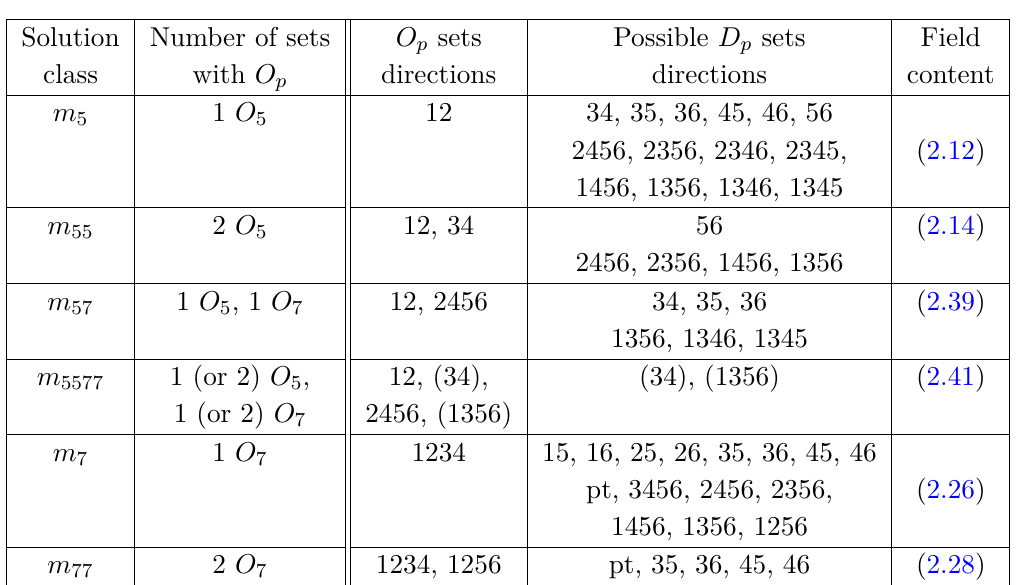
, together with the associated list of allowed variables or field p , 2 O , or 2 O , 1 O , or 2 O , 2 O form just 5 7 5 7 5 7 p /D p